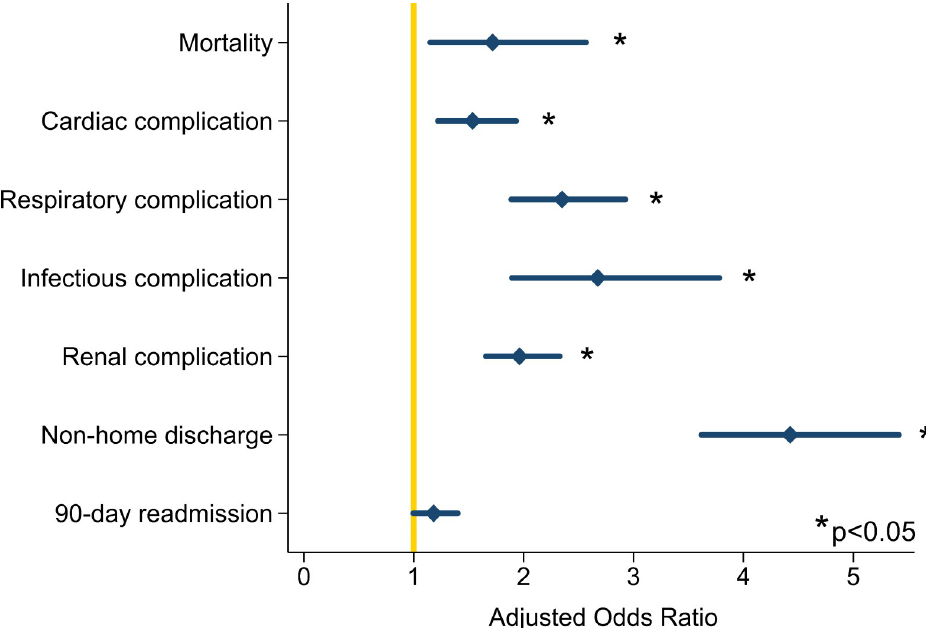
Fig 2. Impact of frailty on risk-adjusted outcomes. Outcomes presented as odds ratio with 95% confidence interval for Frail relative to Non-Frail . C-statistic: mortality (0.83), cardiac complication (0.72), pulmonary complication (0.78), infectious complication (0.84), renal complication (0.80), non-home discharge (0.81) and 90-day readmission (0.63). All multivariable models included adjustment for age, year, sex, chronic lung disease, diabetes, hypothyroidism, end stage renal disease, malignancy, payer status, income quartile, hospital bed size, elective admission and Elixhauser Comorbidity Index.